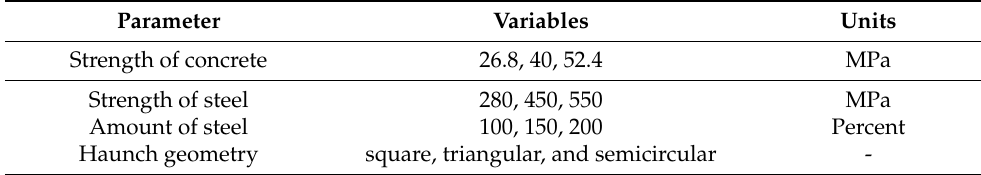
Table 4. Variables for parametric analysis.